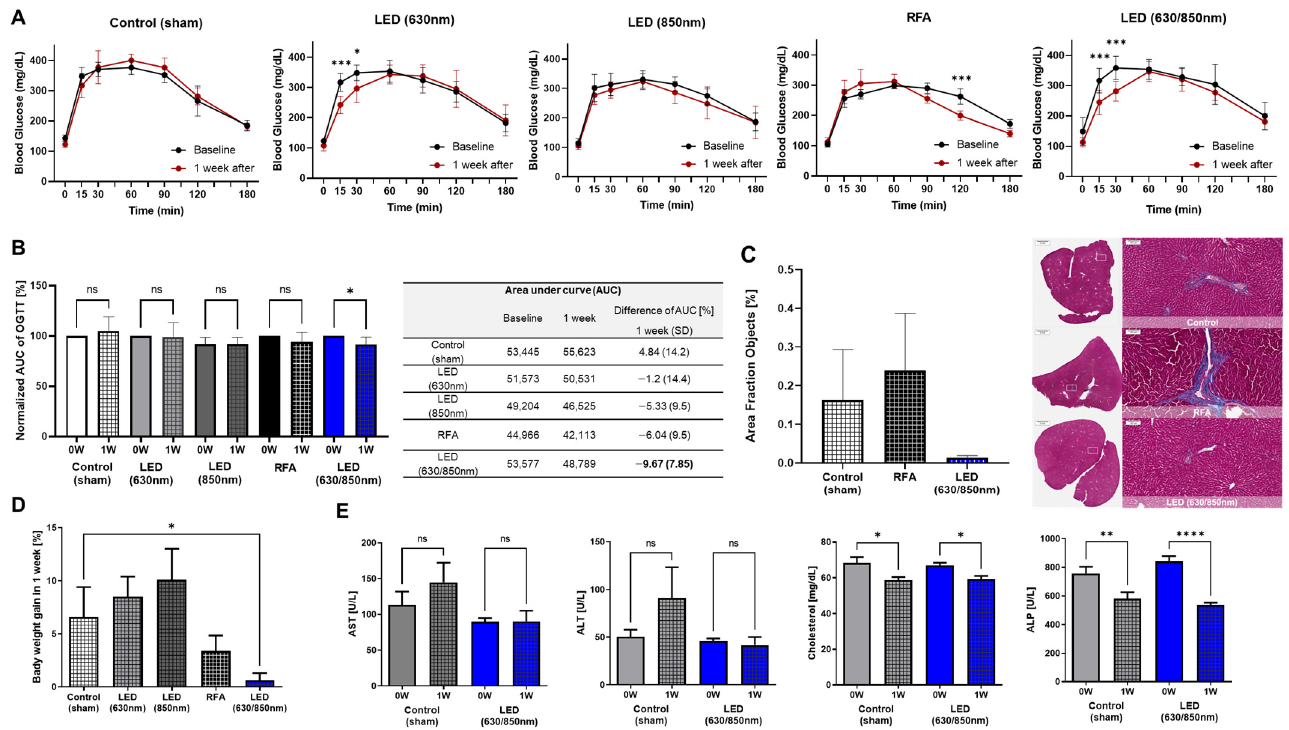
Figure 1. Effects on metabolic improvement in the pilot study with duodenal dual-wavelength (D) photobiomodulation (PBM) with light-emitting diode (LED): Glycemic curves ( A ) during oral glucose tolerance test (OGTT) and normalized area under the curve ( B ) showing the comparison of baseline and 1 week after the procedure in sham control, PBM with 630 nm, PBM with 850 nm, radiofrequency ablation, and PBM with D-LED (630/850 nm) groups. ( C ) In accordance with histological images of Masson’s trichrome staining of the liver tissue, collagen deposition in the liver tissue with D-LED PBM was the lowest compared with those in the sham control and RFA. ( D ) The percentage of body weight gain after the end of the experiment (1-week follow-up). € Comparison of the biochemistry parameters of aspartate aminotransferase, alanine aminotransferase, alkaline phosphatase, and cholesterol levels in sham control and D-PBM groups between 0 and 1 week after PBM. * p < 0.05; ** p < 0.01; *** p < 0.005; **** p < 0.001.